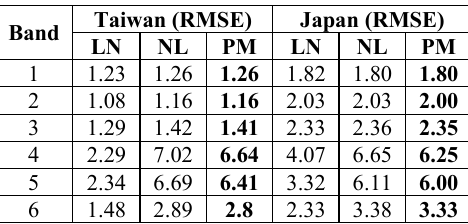
Table 1. Normalized images: Root mean square error (RMSE) You can see the algorithm in the Eq. (7) as